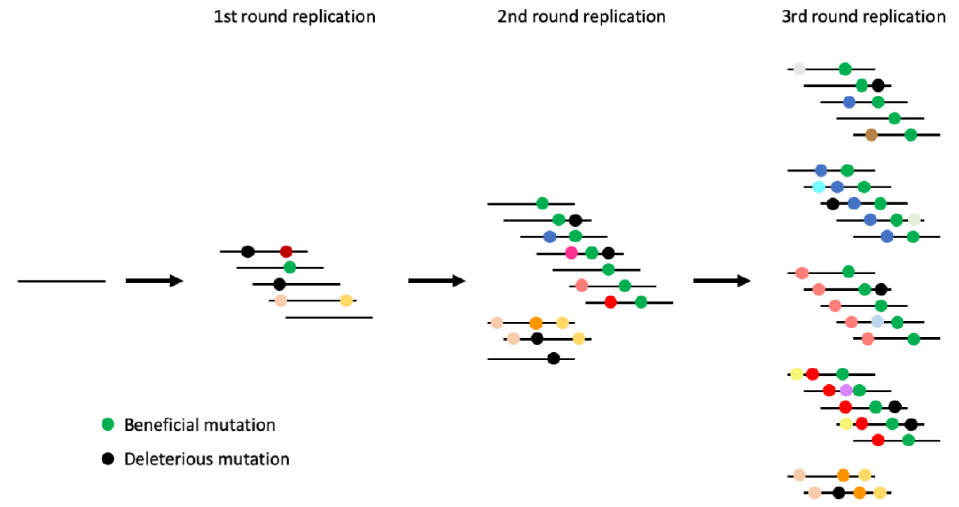
Figure 1. Schematic of mutation accumulation across several rounds of virus replication. Lines represent the virus genome and colored dots represent mutations. Measuring mutation frequency after a single round of replication provides the most accurate representation of the fidelity of the sequence of interest. Collecting samples from subsequent rounds of replication will inadvertently measure the effect of secondary mutants accumulated during replication.